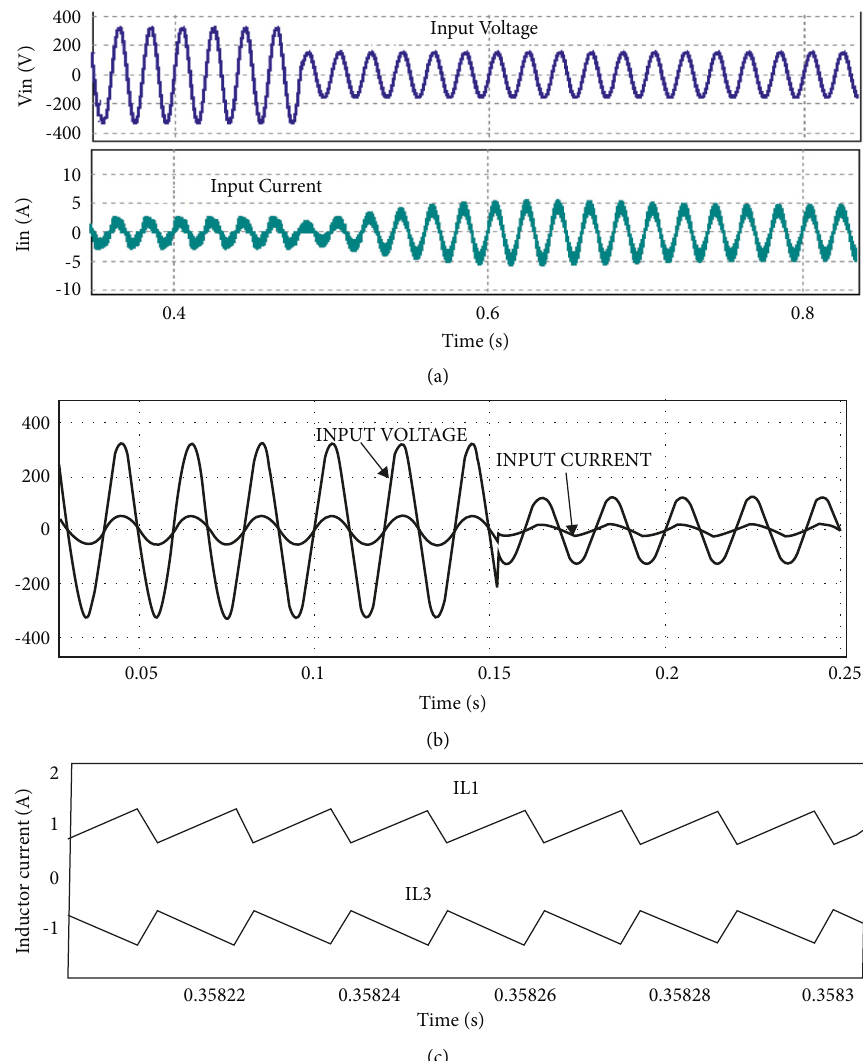
Figure 7: (a) Input supply voltage and current waveforms presenting power factor with 230Vrm (b) Input supply voltage and current waveforms presenting high power factor with 230Vrms and 110 Vrms for RI controller. (c) Current through inductors L 1 and L 3